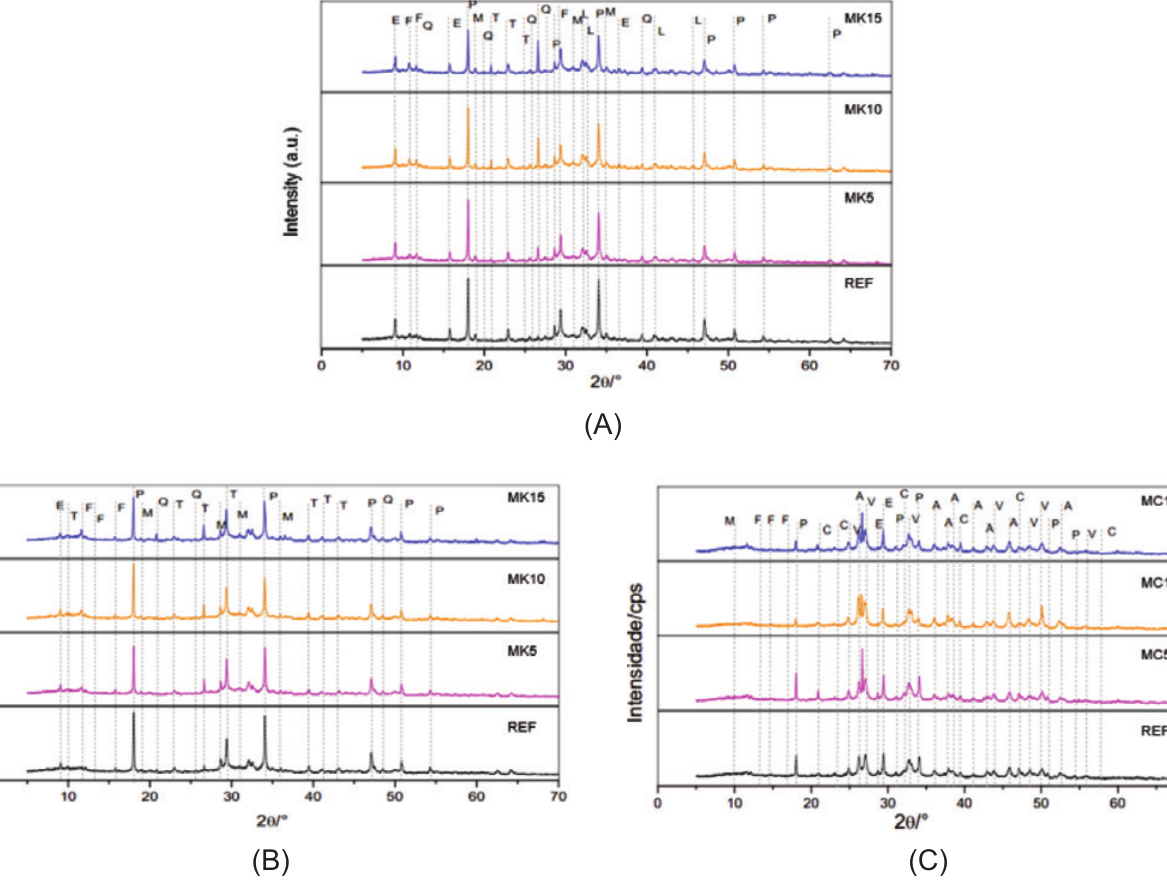
Difratogramas das pastas de cimento contendo diferentes teores de metacaulim, (A) na idade controle (após 28 dias de cura úmida) e aos 91 dias, (B) sem exposição ao CO exposição à câmara de carbonatação, durante 63 dias. E-etringita, T-tobermorita, F-fluorarrojadita, L-larnita, P-portlandita, Q-quartzo, M-muscovita, C-calcita, V-vaterita,